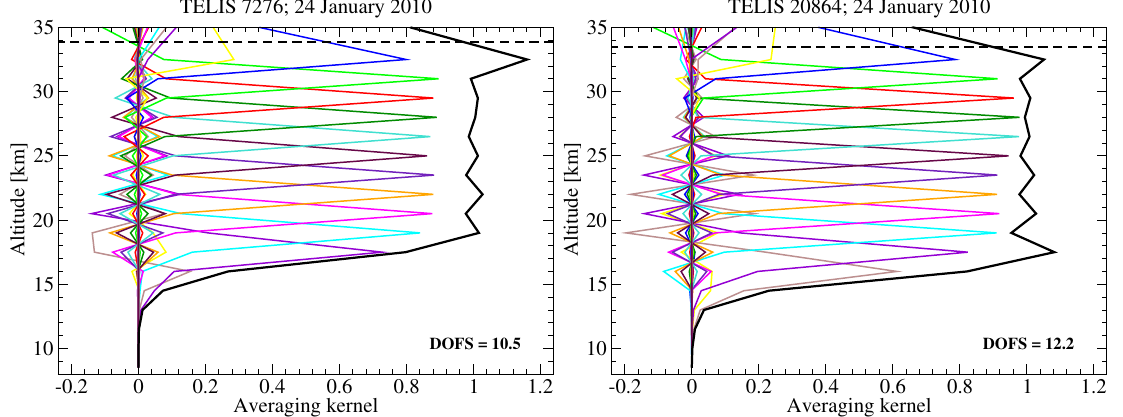
Figure 2. Averaging kernels and degree of freedom for the signal (DOFS) for the O 3 retrievals from TELIS FIR measurements, with identifiers of 7276 and 20864, respectively. Hereafter, the horizontal dashed line indicates the corresponding balloon height, and the solid black line refers to the measurement response obtained by the sum of the elements of each averaging kernel row.